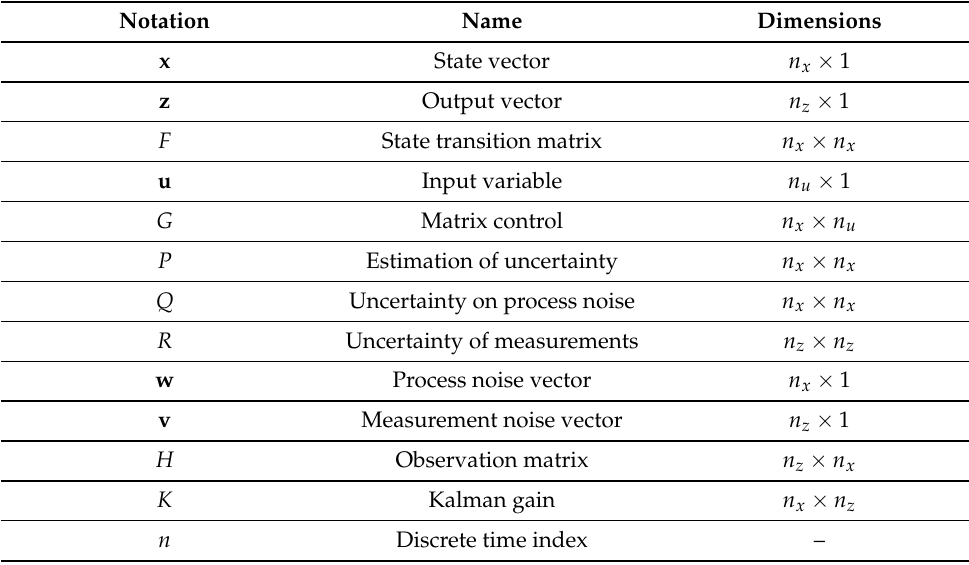
Table 1. The standard notation used for the extended Kalman